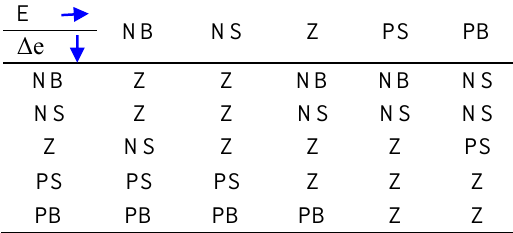
Figure 3. I-V Characteristics of SPV System